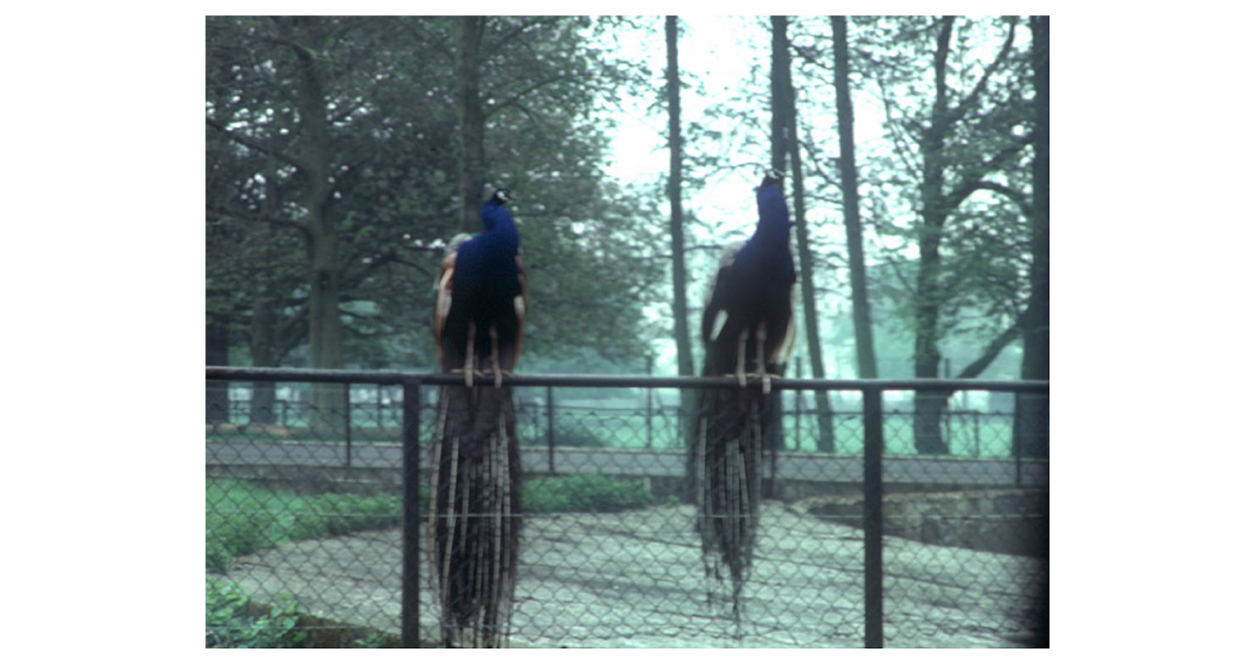
FIGURE 1 | Photograph of two unmarked lek males sitting side-by-side on a fence at Whipsnade. The photograph whilst of quite poor quality clearly shows that there is marked variation in both the length and breadth (number of feathers) in the male’s trains (copyright M.